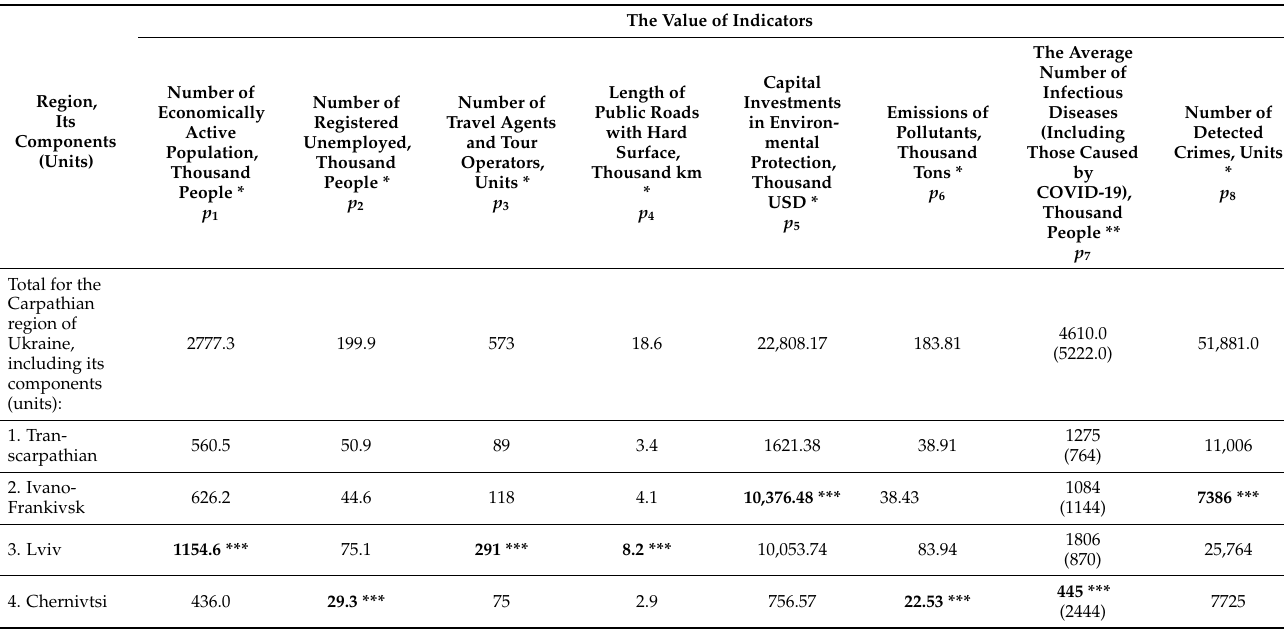
Table 4. The value of indicators for assessing the level of use of the tourist potential of the Carpathian region of Ukraine. The Value of